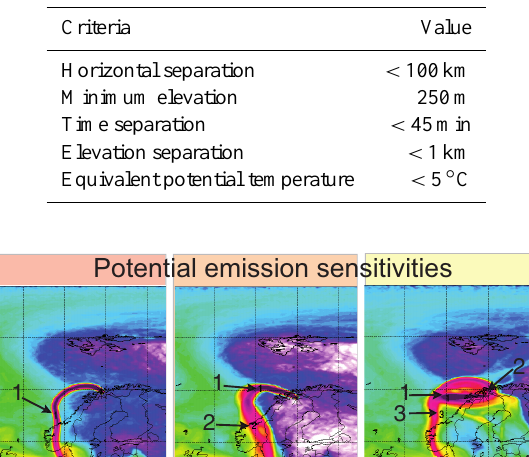
Table 1. Criteria for the Lagrangian matches selection and identifi- cation.